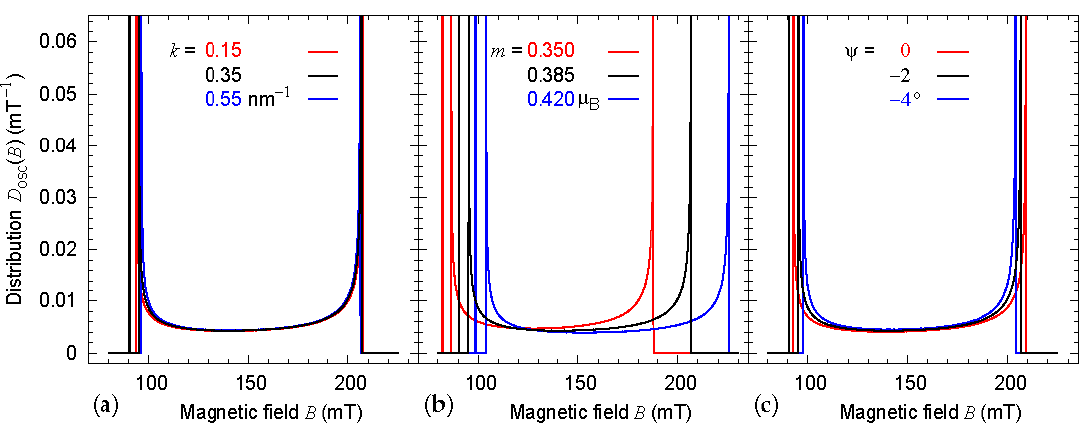
Figure 1. Simulations of the field distribution D osc ( B ) at the muon localization sites as a function of the three magnetic parameters k , m , and ψ , respectively in ( a – c ). Note that the value of B sgl = 91 mT is essentially independent of k and ψ